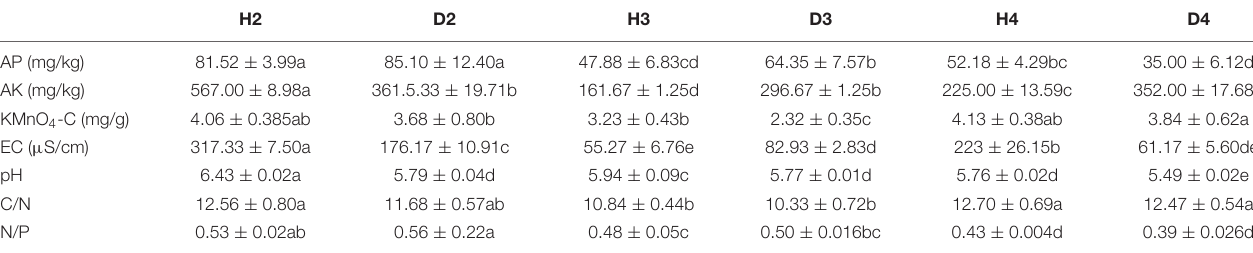
TABLE 1 | Physicochemical properties of soils associated with different aged, healthy and diseased American ginseng (AG) plants. H2